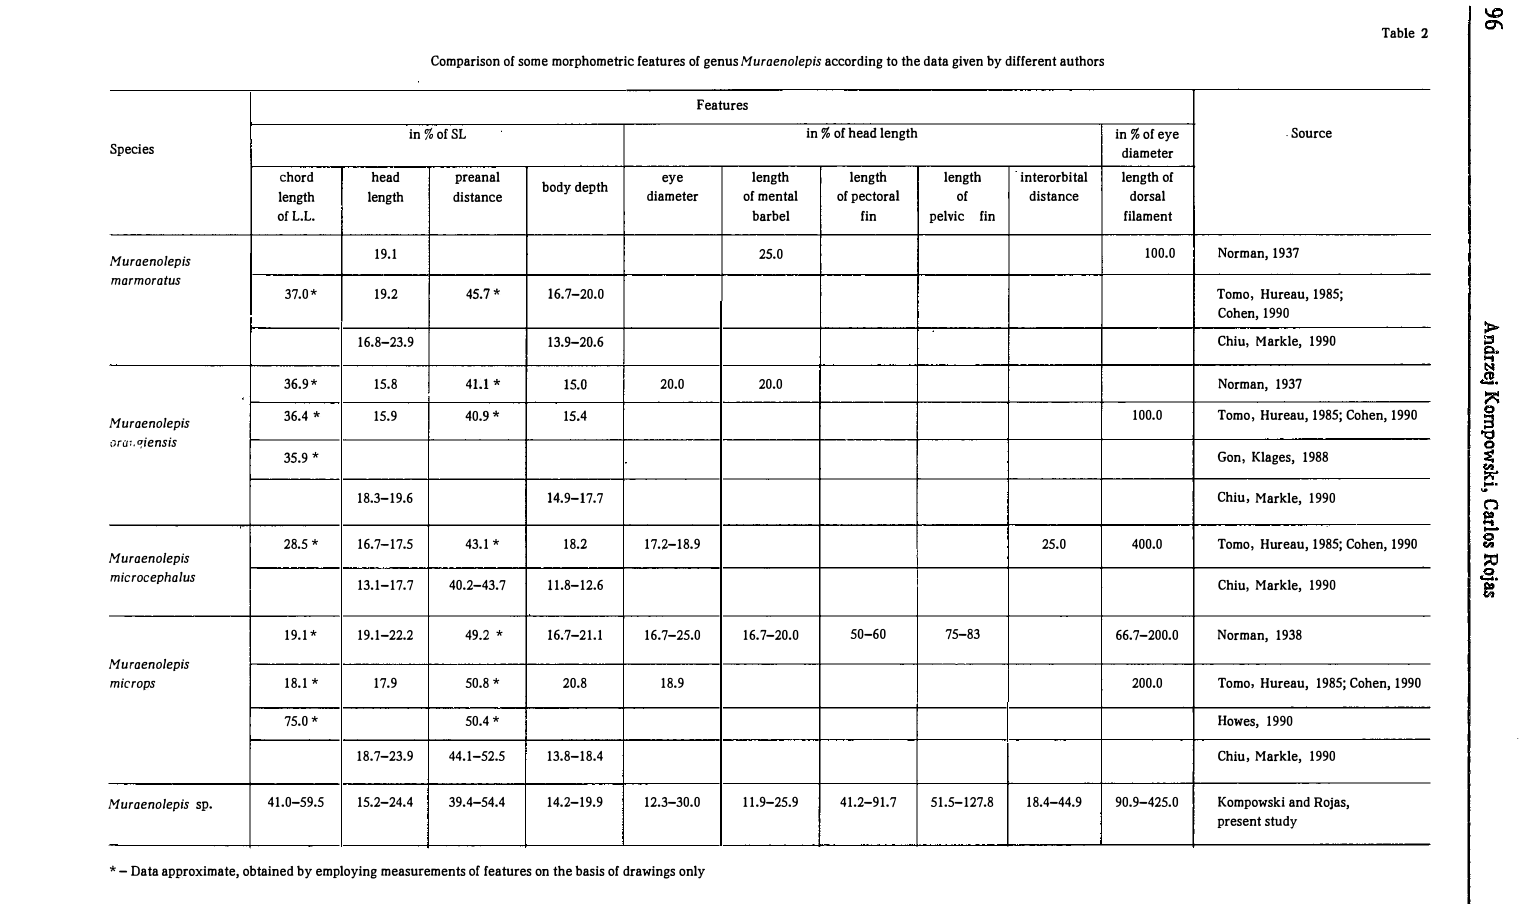
Comparison of some morphometric features of genus Muraenolepis according to the data given by different